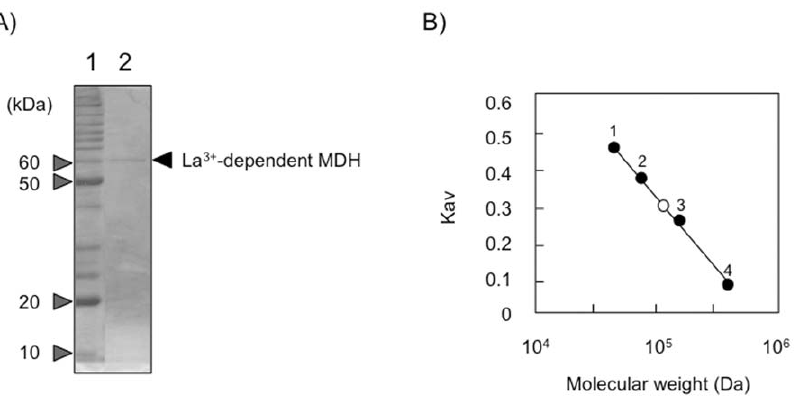
Figure 4. SDS–PAGE analysis (A) and molecular weight (B) of purified MDH from strain AM1 grown on methanol/Ca 2 + + La 3 + medium. A, Lane 1, marker proteins; lane 2, purified MDH. B, Marker proteins were: 1, ovoalbumin (43 kDa); 2, conalbumin (75 kDa); 3, aldolase (158 kDa); and